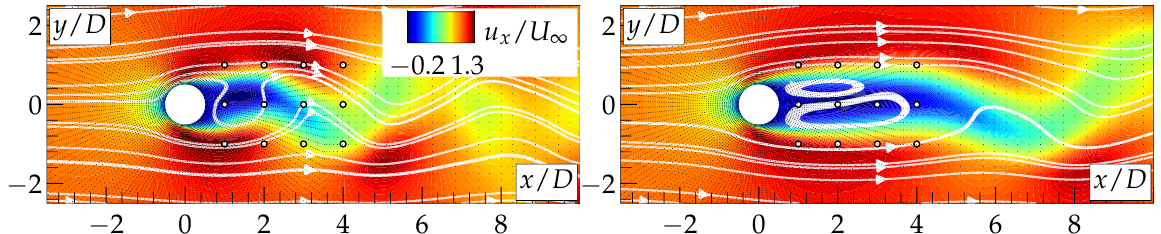
Figure 6. Typical instantaneous streamwise velocity field with streamlines: ( Left ) stationary cylinder; and ( Right ) DRL-based control for c1e80 after sufficiently long time interval to establish a steady regime. See also the Supplementary Material Video S1 (also available at: https://youtu.be/9X8XtHk0R84). The array of 4 3 white points corresponds to pressure sensors serving as the input for the neural network × (see Figure 2).